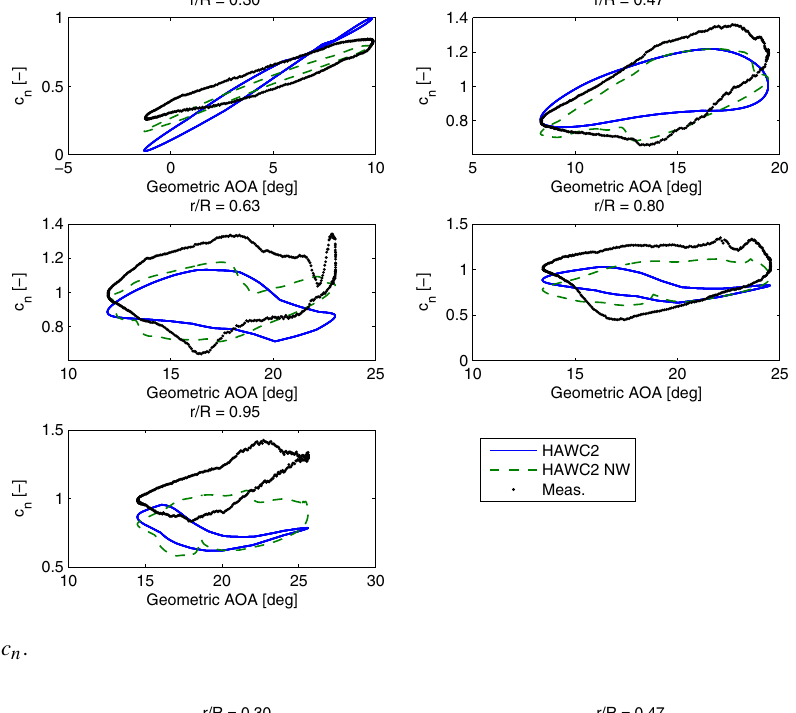
Figure 8. Case O47320; c n .